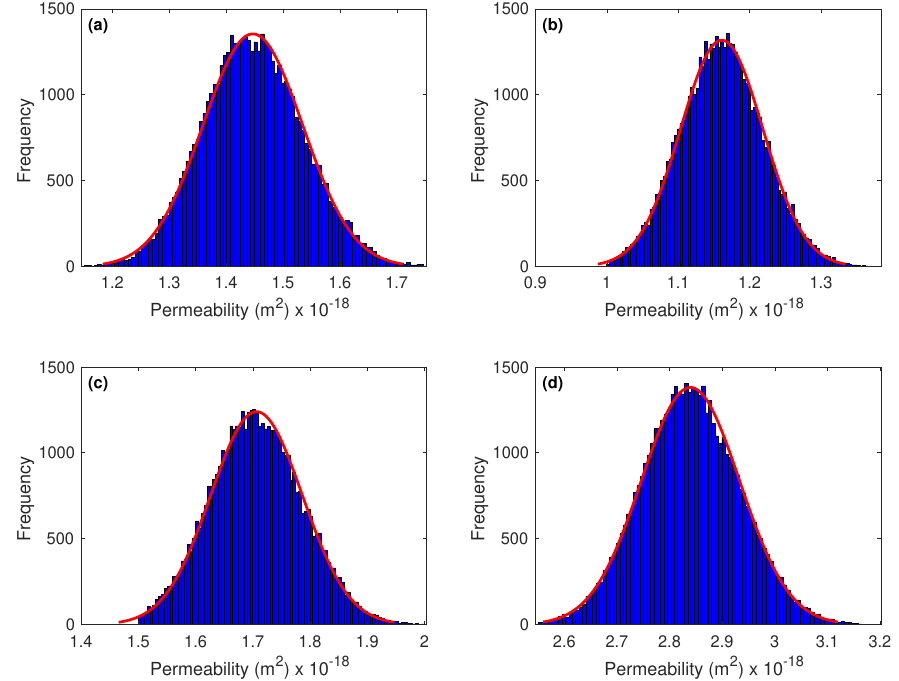
Figure 5. Posterior probability density functions of the intrinsic permeability resulting from the MCMC simulation. Estimates are shown for samples cured in standard condition. ( a ) GGBS0; ( b ) GGBS45; ( c ) GGBS60; and ( d )